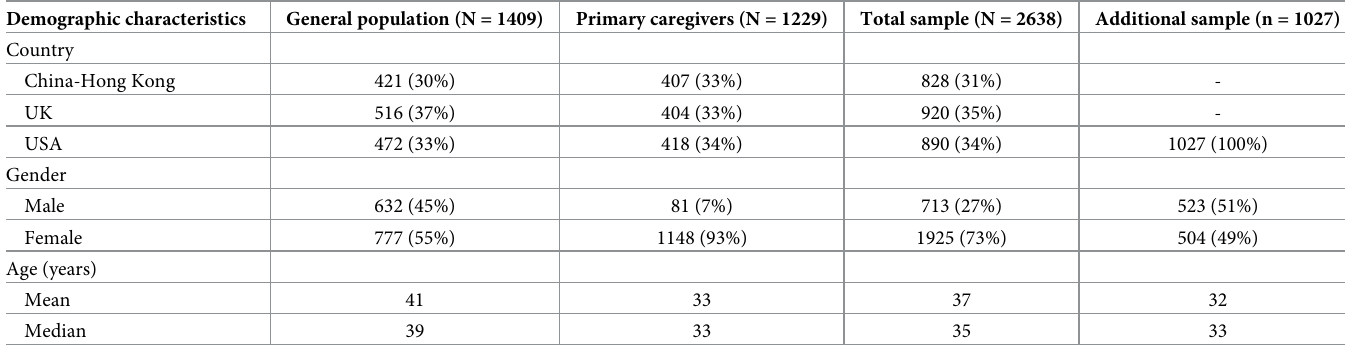
Table 1. Demographics of the various study